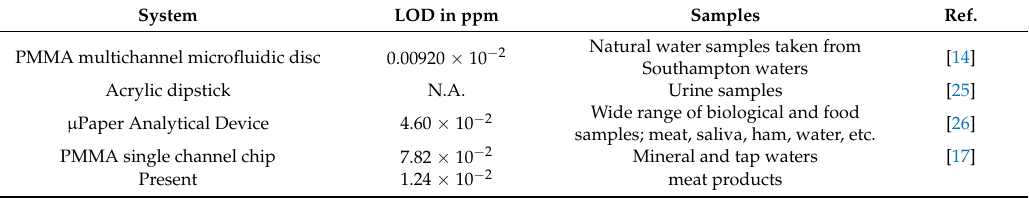
Table 1. Detection of nitrite in food and biological samples using different systems.